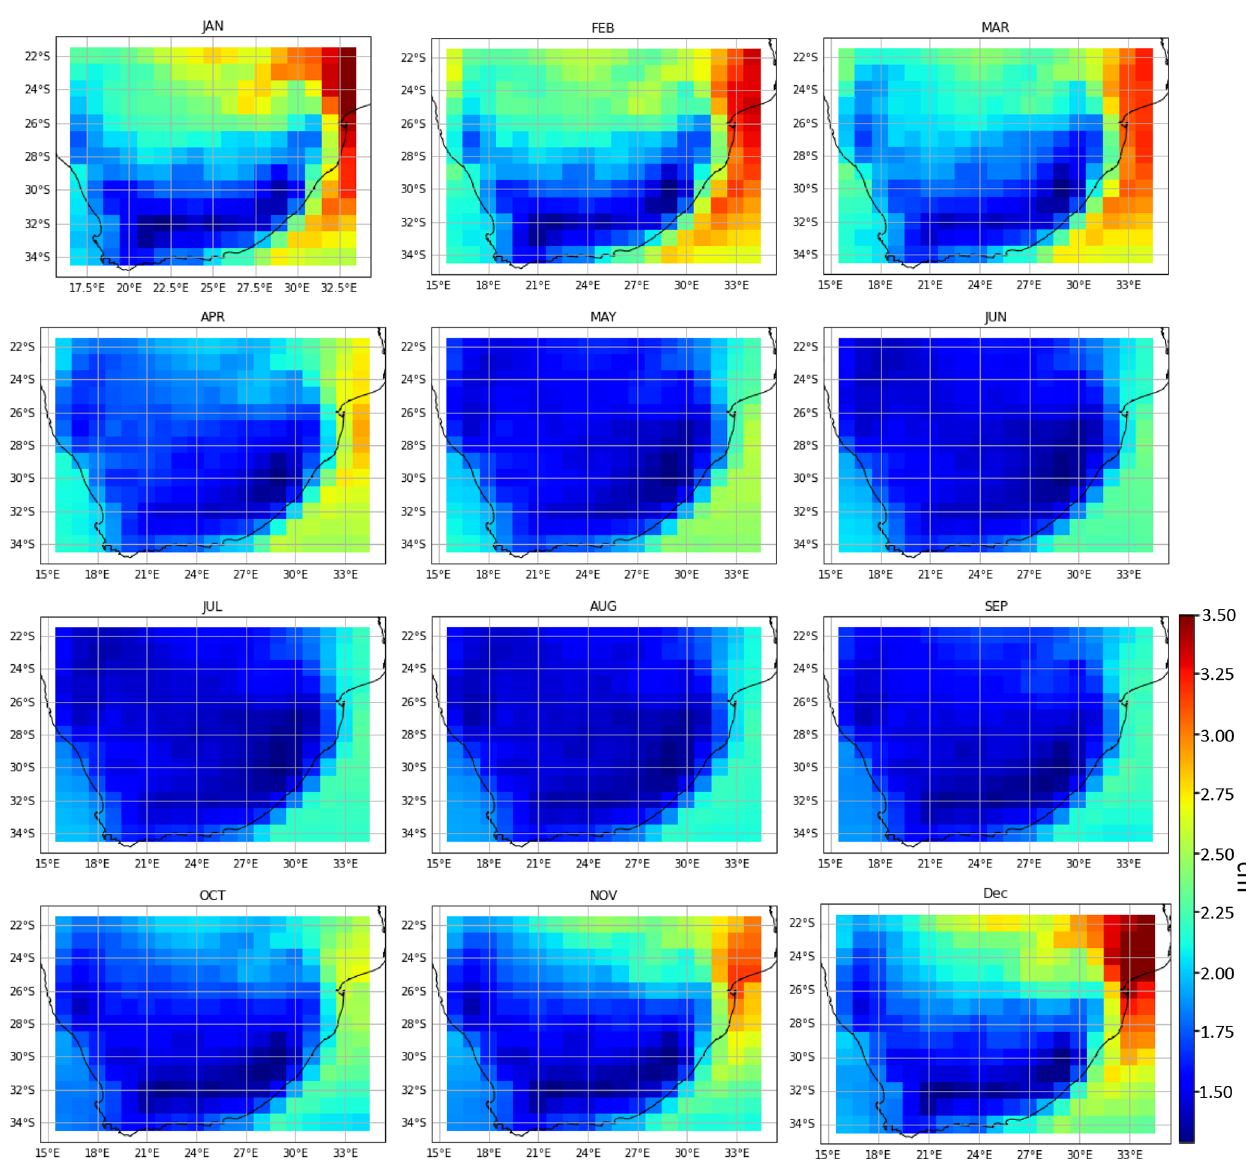
Figure 5. Average spatial distribution of atmospheric water vapour (AWV) in cm over South Africa from MODIS data for 10